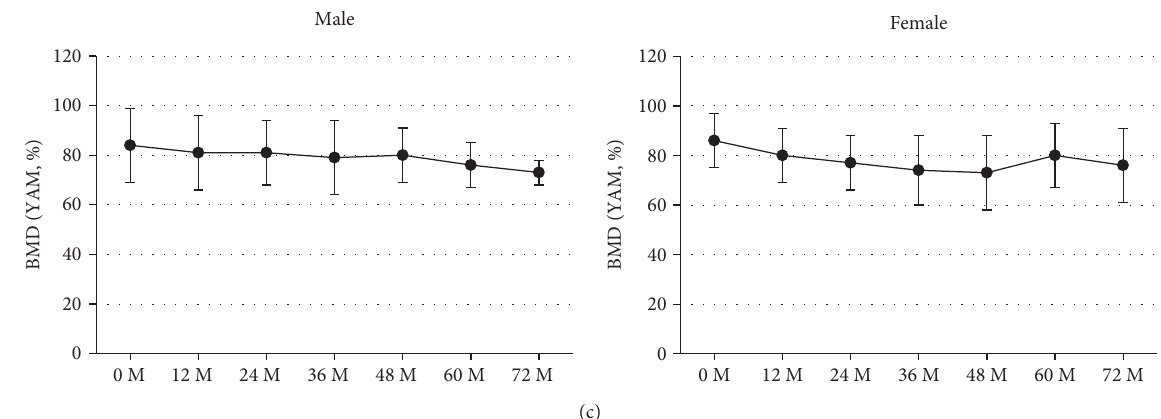
Figure 2: Levels of eGFR (mean ± SD) at baseline and at 12, 24, 36, 48, 60, and 72 months following renal transplantation (a) at baseline and at 12, 24, 36, 48, 60, and 72 months (b) and levels of total proximal femur BMD (mean ± SD) at baseline and at 12, 24, 36, 48, 60, and 72 months following renal transplantation by sex (c). Patients who received parathyroidectomy were excluded. eGFR, estimated glomerular filtration rate; BMD, bone mineral density. ∗ P value < 0.05 vs. 0M, Tukey’s test. ∗∗ P value < 0.05 vs. 12M, Tukey’s